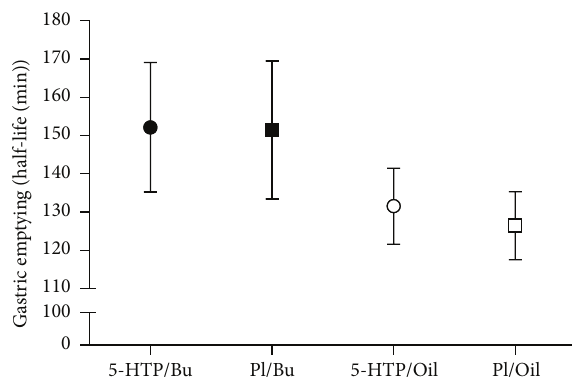
Figure 1: Half-life of gastric emptying. The influence of 5- hydroxytryptophan (5-HTP) and fatty acid ingestion on the half- life (HLF) of gastric emptying. Participants received a capsule with either 5-HTP or placebo (Pl). Additionally they ingested a standard meal supplemented with 100 𝜇 L 13 C octanoid acid and either butter (Bu) or olive oil (Oil). A breath test sample was taken every 15min over the next 4 hours. The data is presented as means ± SE of the HLF of gastric emptying. Statistics: HLF; no statistical significance within the 4 conditions. There was a significant difference between the summarized butter and olive data, 𝑃 < 0.05